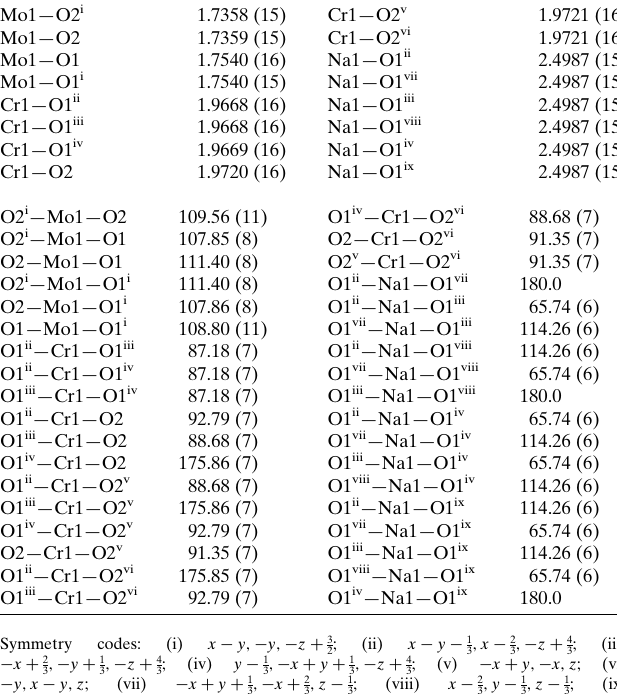
Table 1 Selected geometric parameters (A˚ , (cid:4) ).